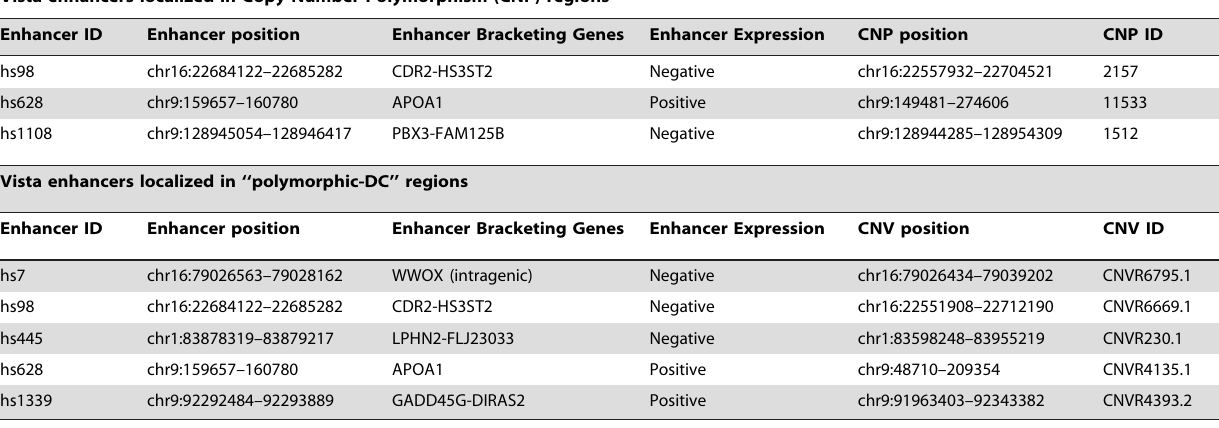
Table 1. VISTA enhancer loci localized in polymorphic CNV regions.